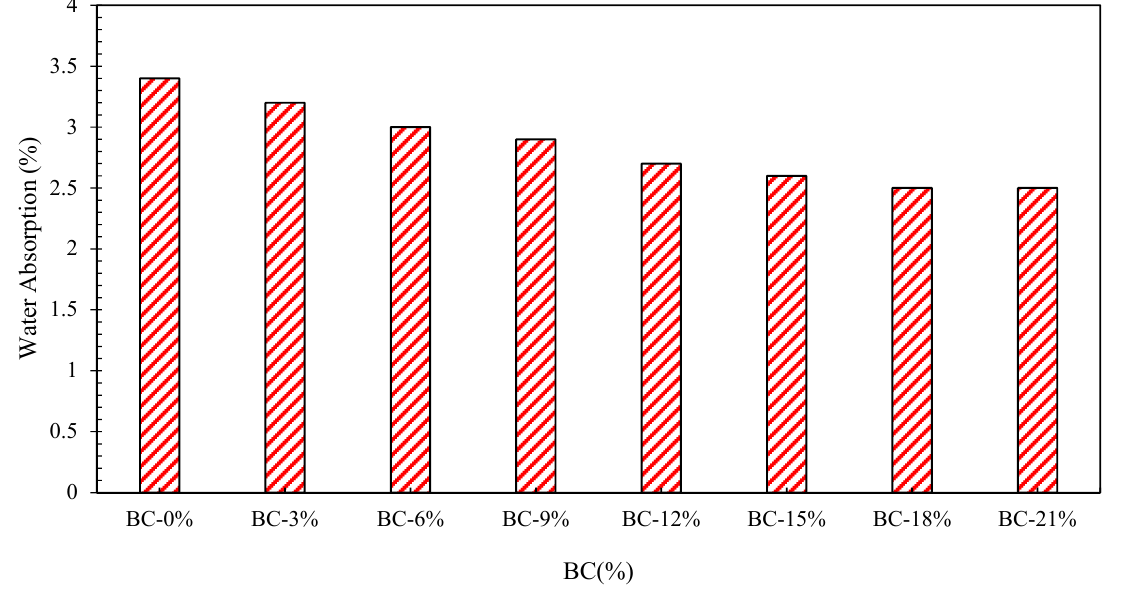
Figure 14. Water absorption (data source [44]).